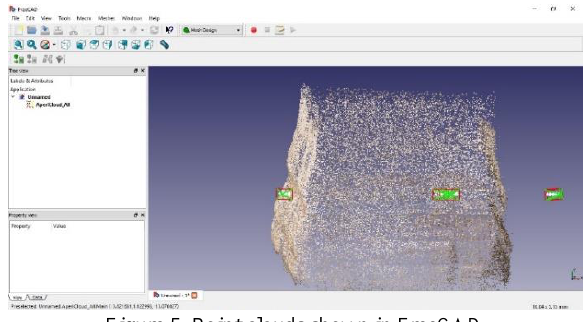
Figure 5. Point clouds shown in FreeCAD